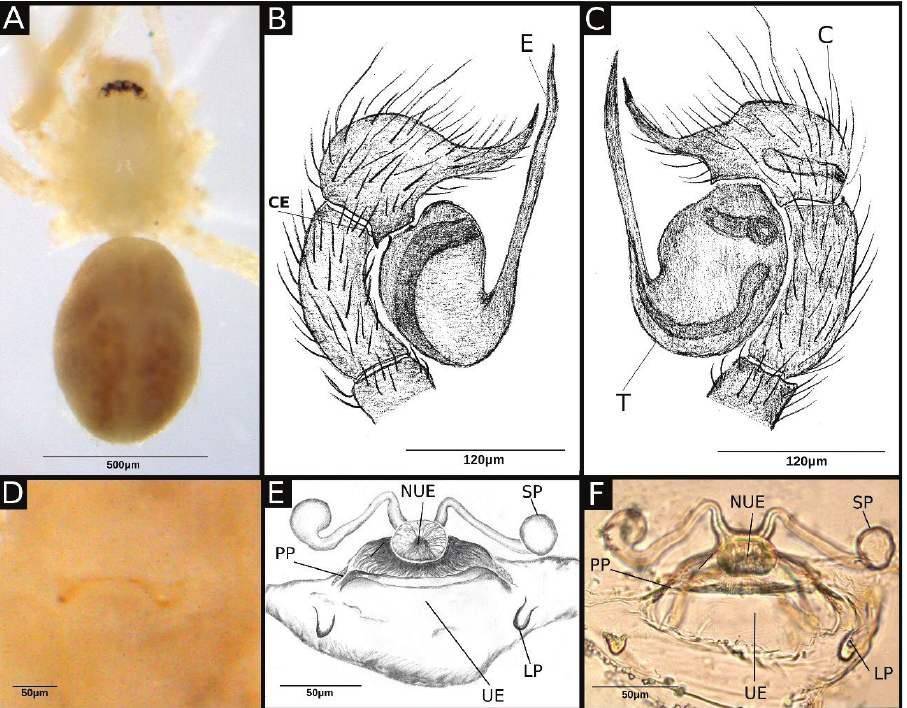
Figure 7. Ochyrocera magali sp. nov., female (IBSP 196412) A habitus, dorsal view B male palp, retrolateral view C same, prolateral view D same, dorsal view E epyginal plate, ventral view F female genitalia (IBSP 188947), enzyme cleared, dorsal view. Abbreviations: C, cymbium; CE, cymbial extension, E, embolus, LP, lat- eral pockets, NUE, neck of uterus externus; PP, pore-plate, SP, spermathecae; T, tegulum; UE, uterus